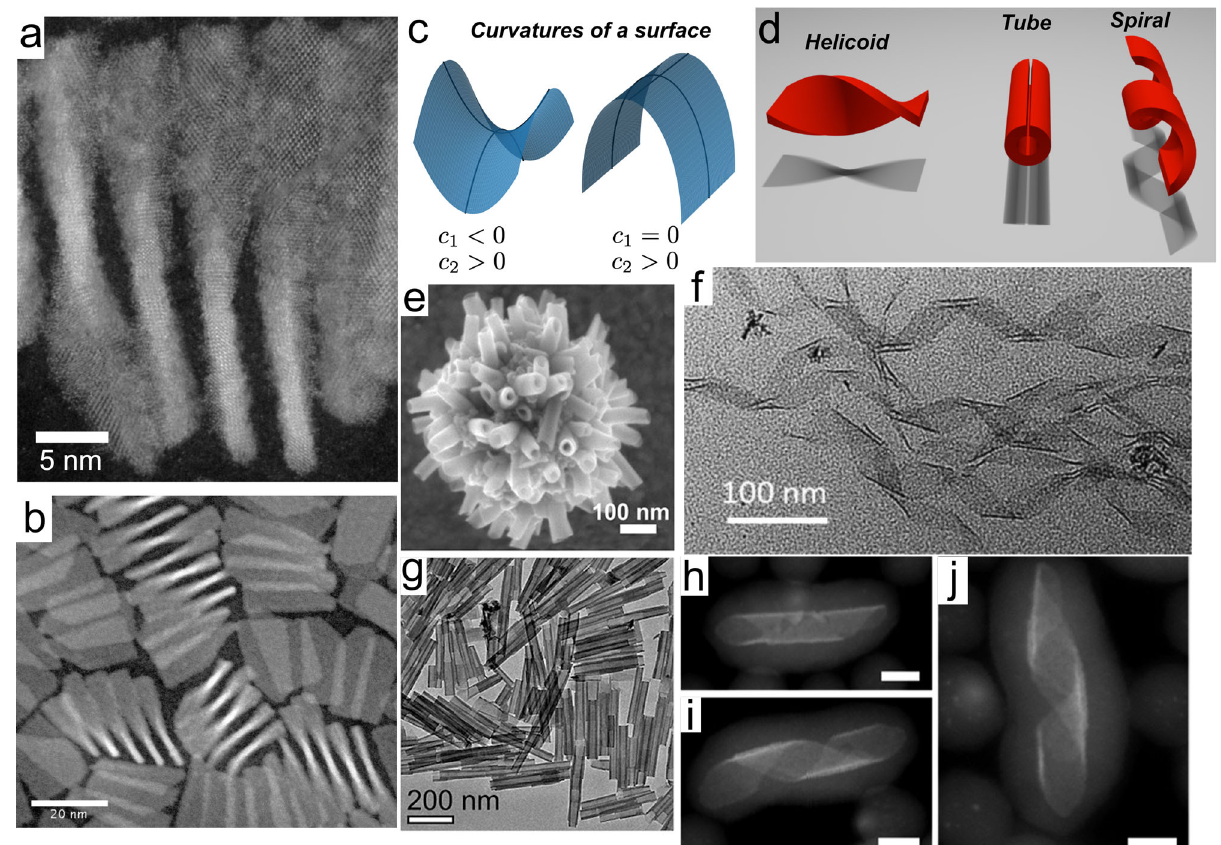
Fig. 2 Geometry of curved CdSe NPLs. a , b STEM images of 5 ML helicoidal NPL 46 . c Representation of the principal local curvatures of a surface. Left: the two principal curvatures have opposite signs leading to a negative Gaussian curvature κ 2 = c 1 × c 2 . Right: the Gaussian curvature is zero. d Different conformations of a ribbon. The shadows below the different shapes correspond to their projections on a surface and should thus resemble the TEM images of the corresponding particles. e , g CdSe 3 ML NPLs folded into tubular structures. Reprinted with permission from refs. 22,29 . Copyright 2019 and 2013 American Chemical Society. f 3 ML NPLs adopting a spiral ribbon geometry. Reprinted with permission from ref. 49 . Copyright 2019 American Chemical Society. h – j Spiral ribbons coated with a silica shell. Reprinted with permission from ref. 47 . Copyright 2014 American Chemical Society. Scale bars correspond to 5